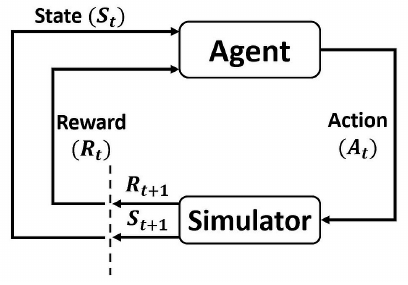
Figure 1. The general reinforcement learning framework.